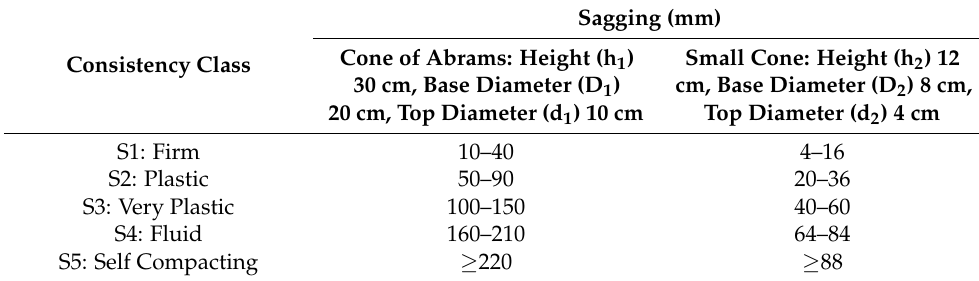
Table 6. Slump test cone parameters utilized to understand SCM.